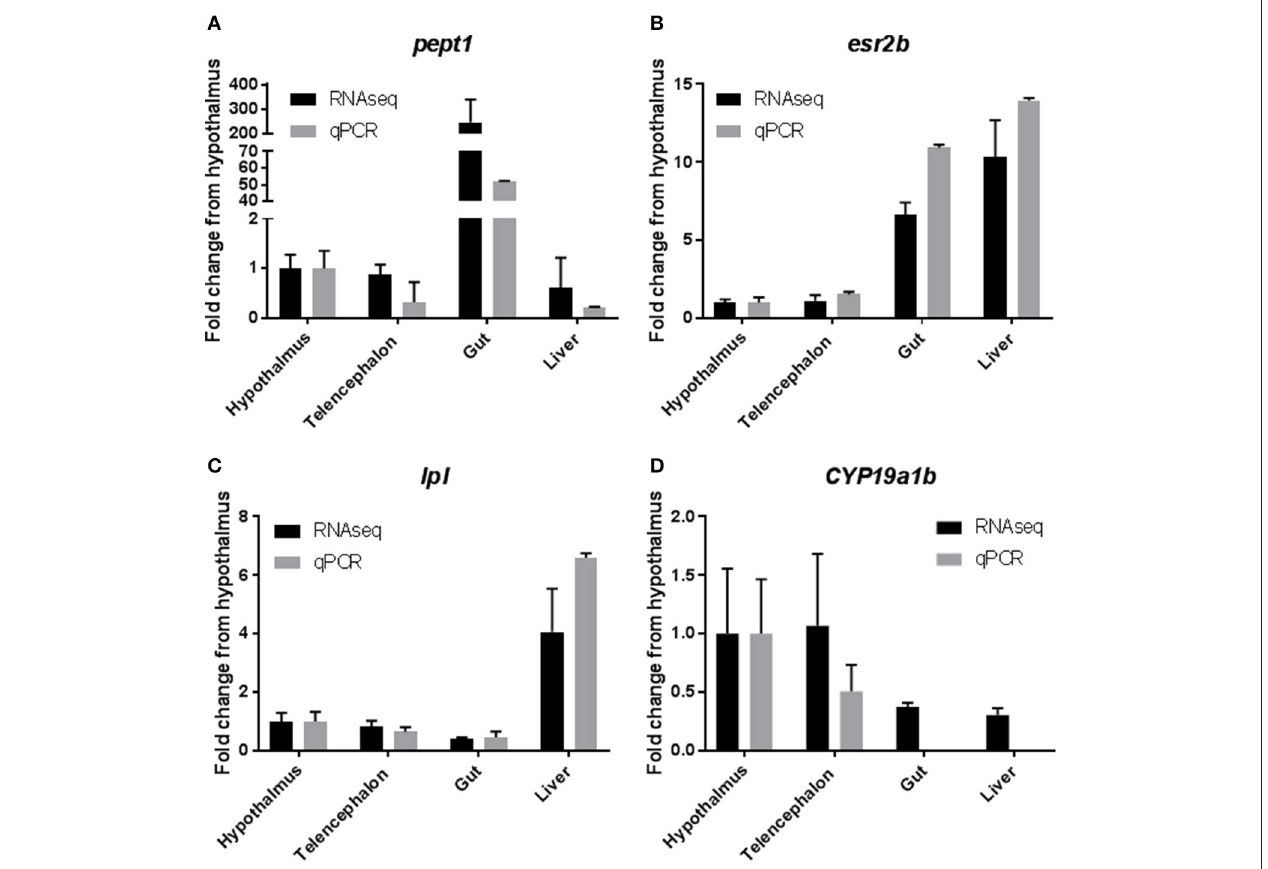
FIGURE 5 | Confirmation of RNAseq results with quantitative PCR. Selected genes from the RNAseq data set were used to confirm the results by qPCR. Results are presented as mean ± standard deviation fold change from the hypothalamus tissue. (A) Peptide Transporter 1 ( pept1 ). (B) Estrogen Receptor 2b ( esr2b ). (C) Lipoprotein Lipase ( lpl ). (D) Cytochrome P450 19a1b ( cyp19a1b ).